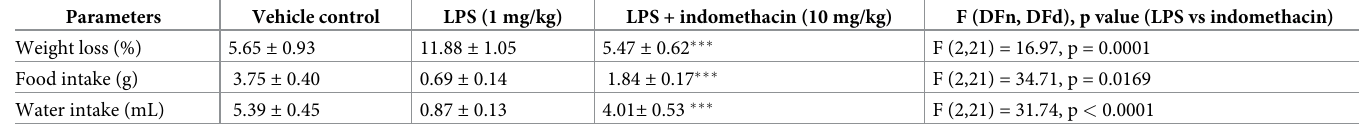
Table 1. Bodyweight changes, food, and water intake after administration of